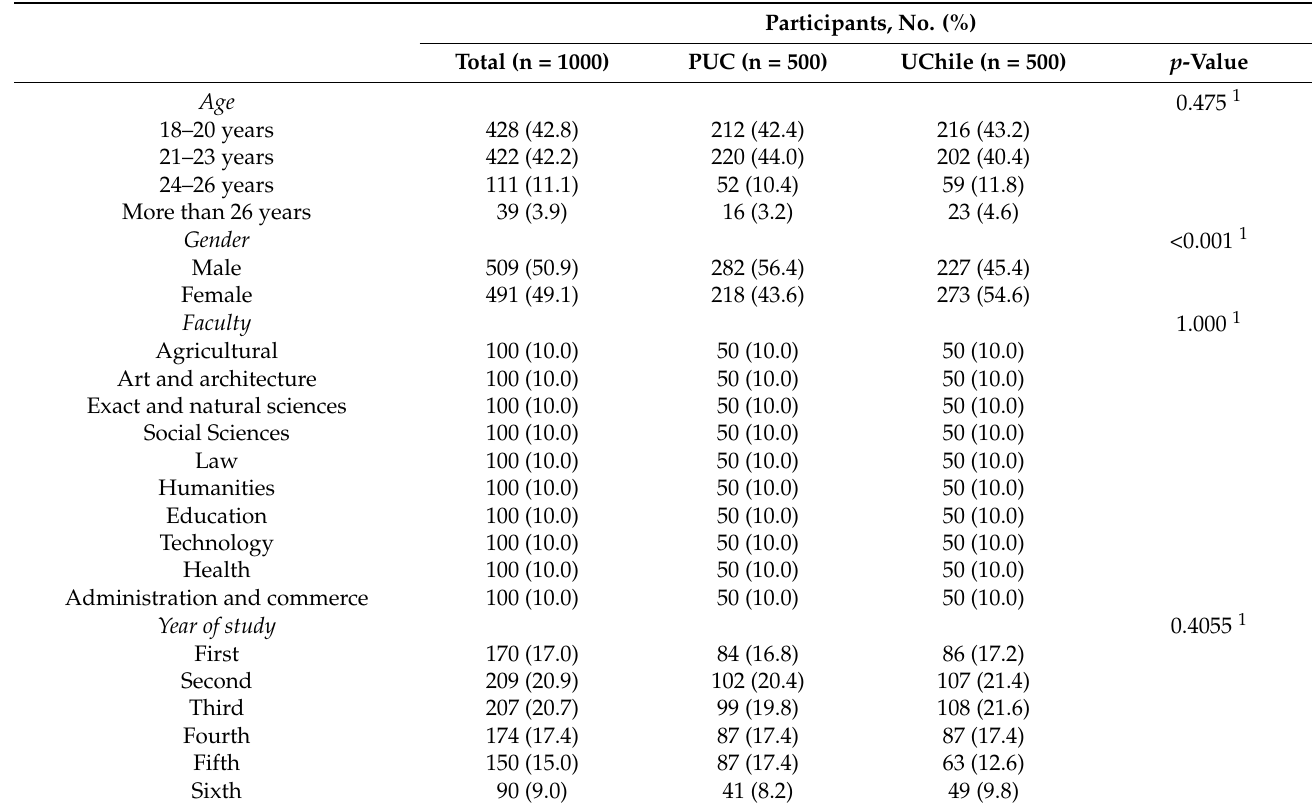
Table 1. Characteristics of respondents studying Pontificia Universidad Cat ó lica de Chile (PUC) and Universidad de Chile (UChile).